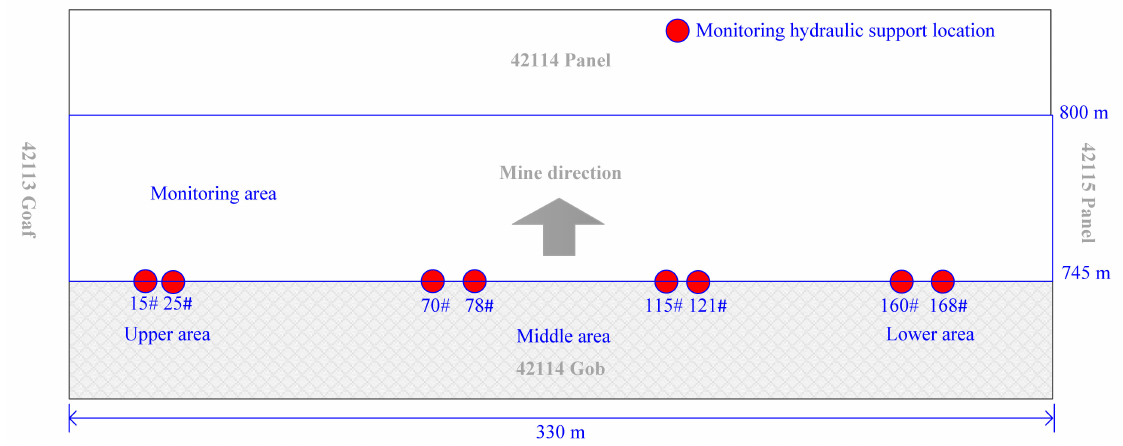
Figure 3. The monitoring location of hydraulic